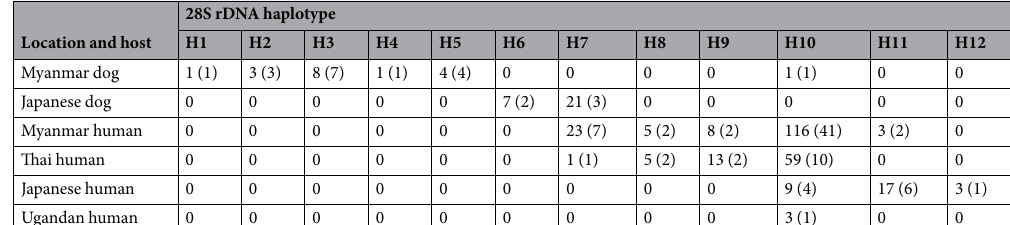
Table 5. 28S rDNA haplotypes identified in S . stercoralis isolated from humans or dogs. Numbers outside the brackets indicate the number of isolates typed as respective haplotypes. Numbers inside the brackets indicate the number of host animals from which worms with respective haplotypes were isolated. Note that the sum of the host numbers (103) shown on this table is more than the actual host number (86), because some hosts harbored worms belonging to different